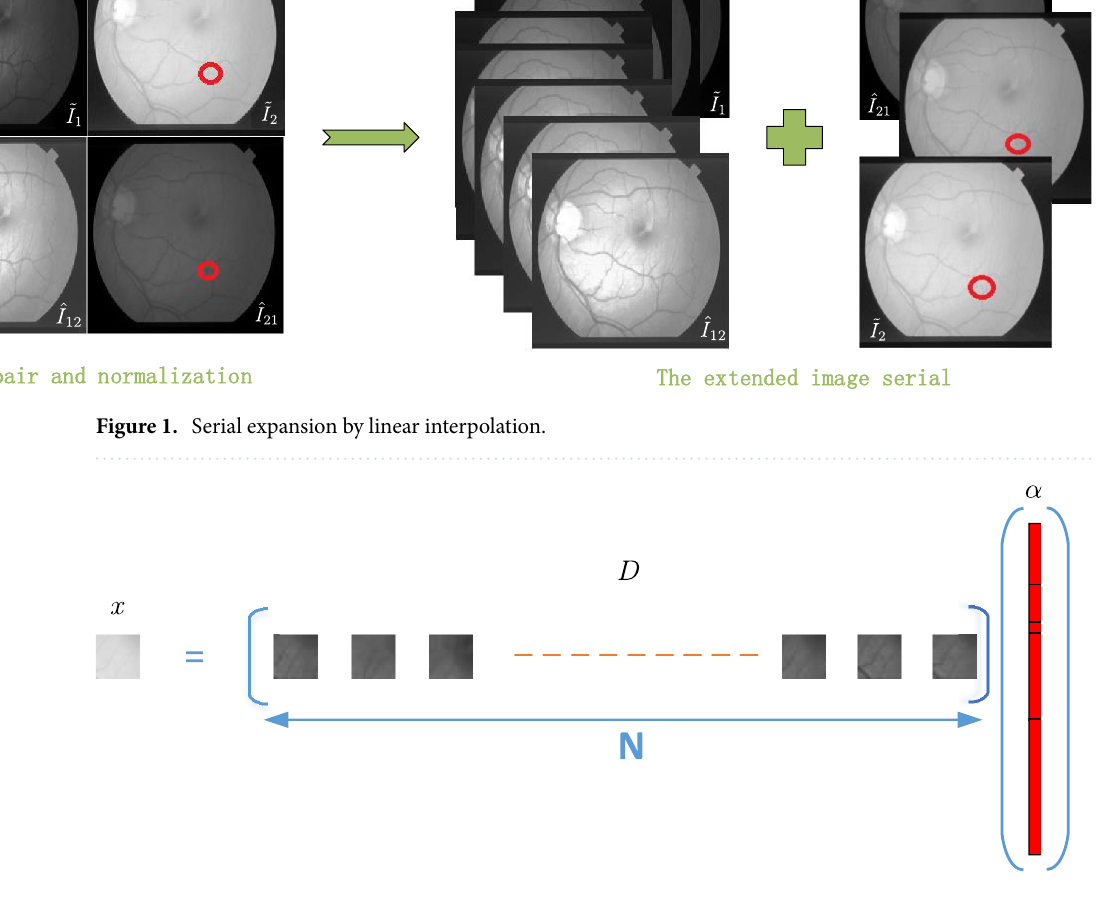
Figure 2. The local reconstruction and dictionary sparse representation of current image